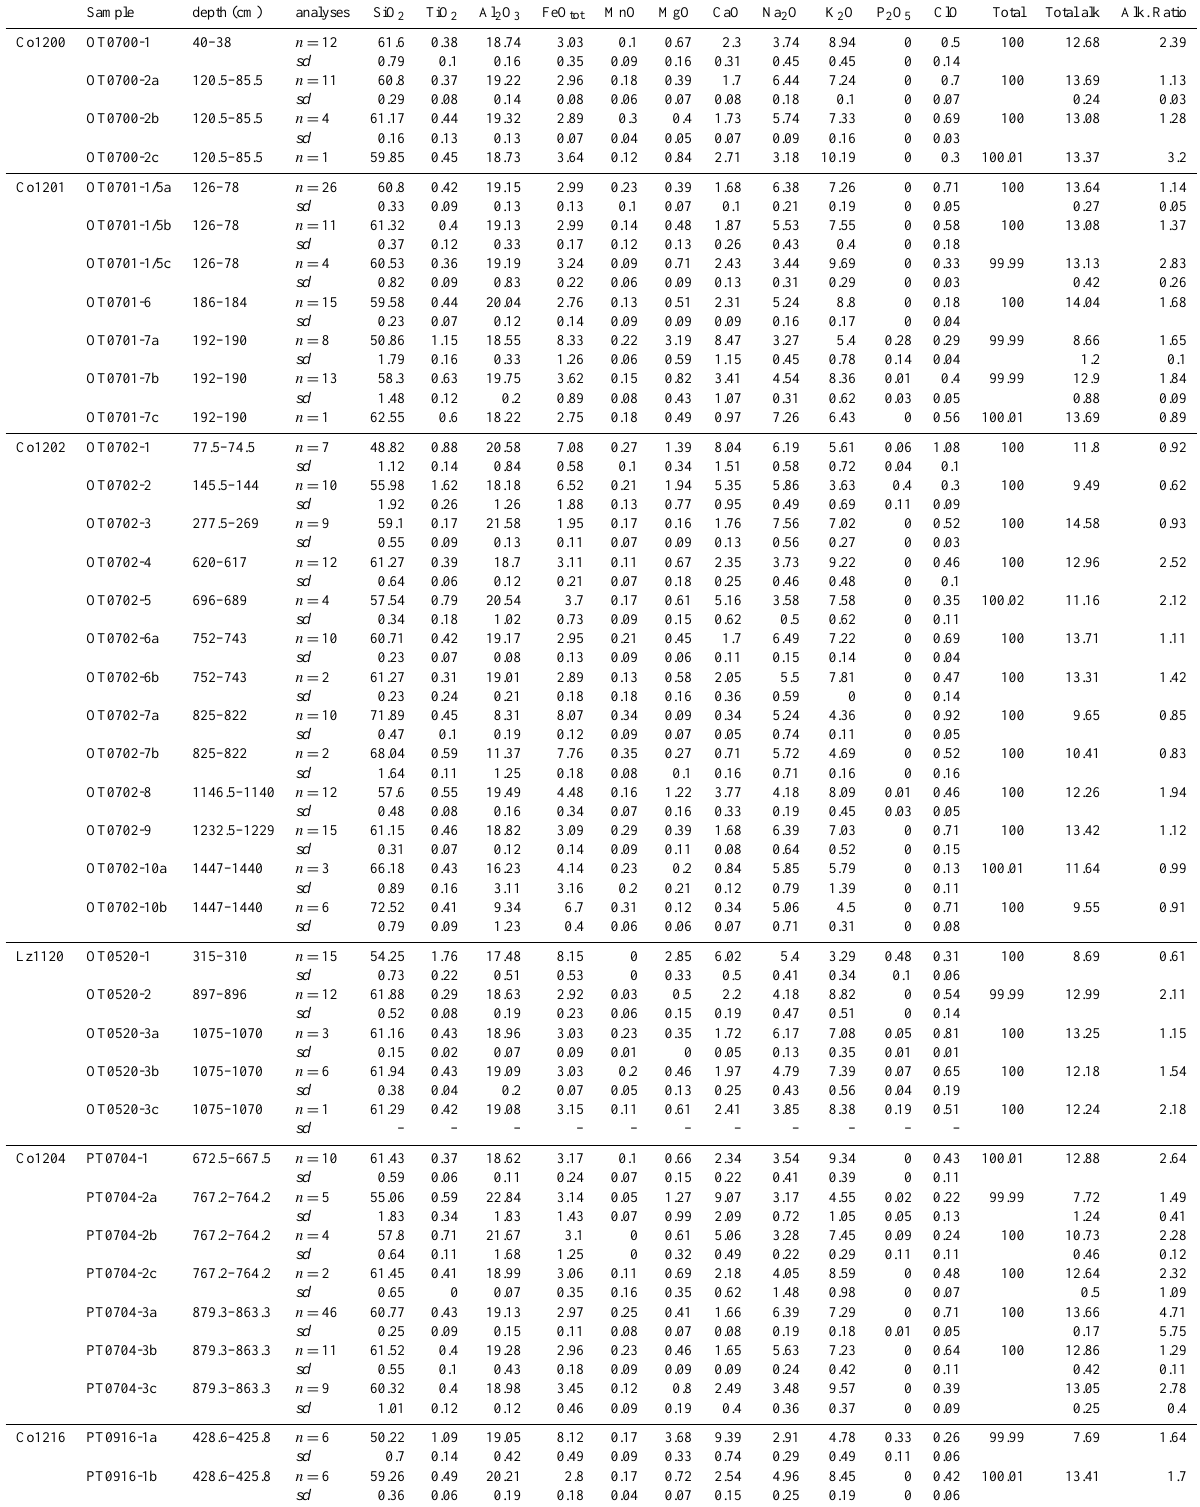
Table 2. Average EDs analyses of glass shards of tephra layers and cryptotephras from the studued and reviewed cores.